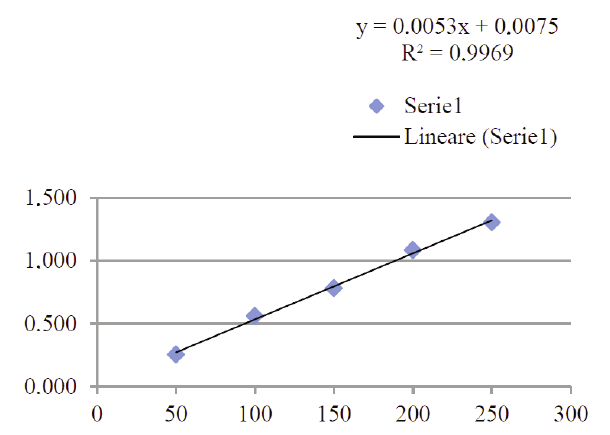
Fig. 2 ­ Standard graph of total phenol measurement.